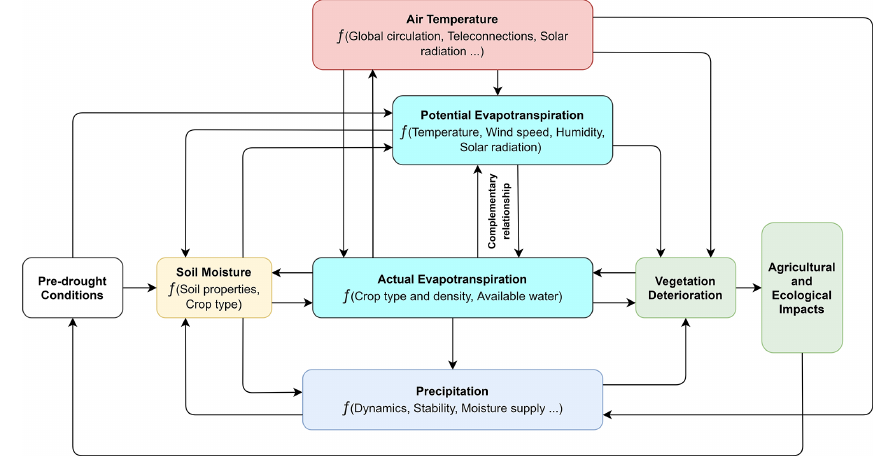
Figure 1. Schematic of flash drought states and processes. Arrows indicate suggested feedback directions and their relation to the process or variable (for simplicity, not all proposed feedbacks are represented here). Each color represents a core group of processes used to represent the different definitions of the onset of flash drought